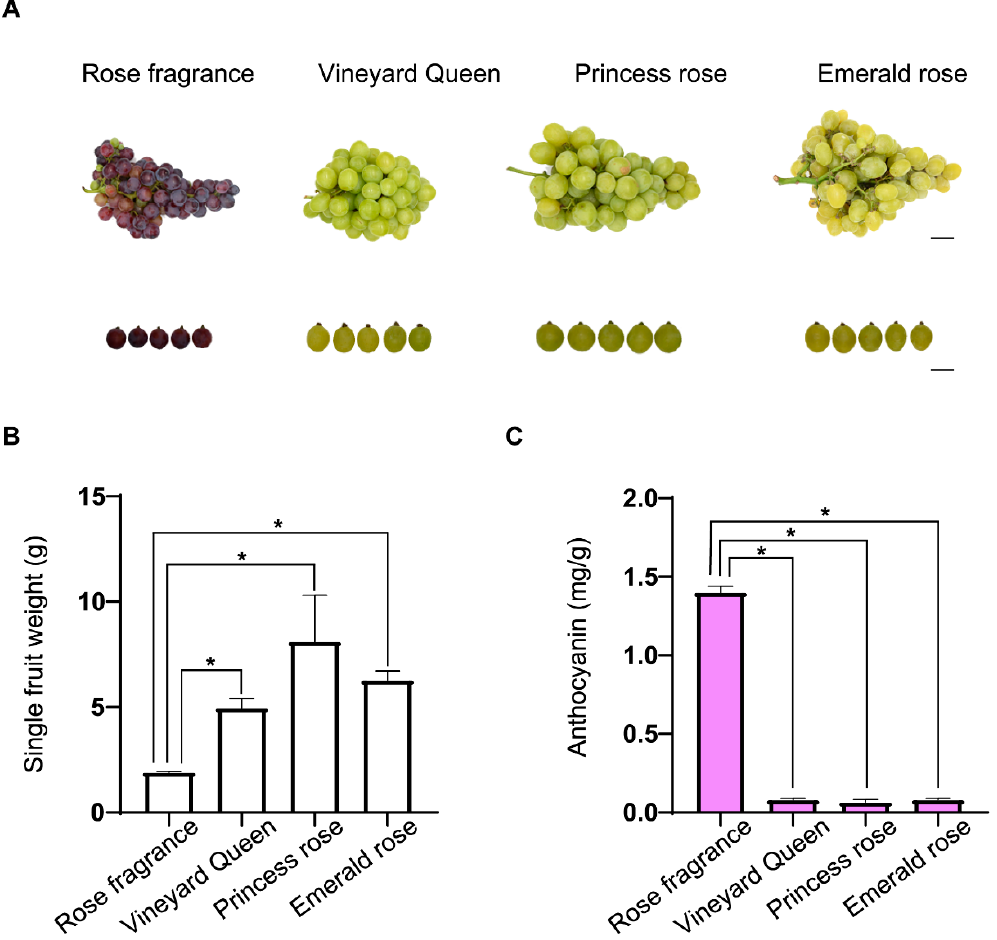
Figure 1. Phenological and physiological indicators. ( A ) Single strings and single-tree forms of grape varieties. Bar = 1 cm. ( B ) Single fruit weight of grapes. ( C ) Anthocyanin content of grapes. Error bars show the standard error of the mean (SEM; n = three biological replicates). * p < 0.05 (Student’s t -test).